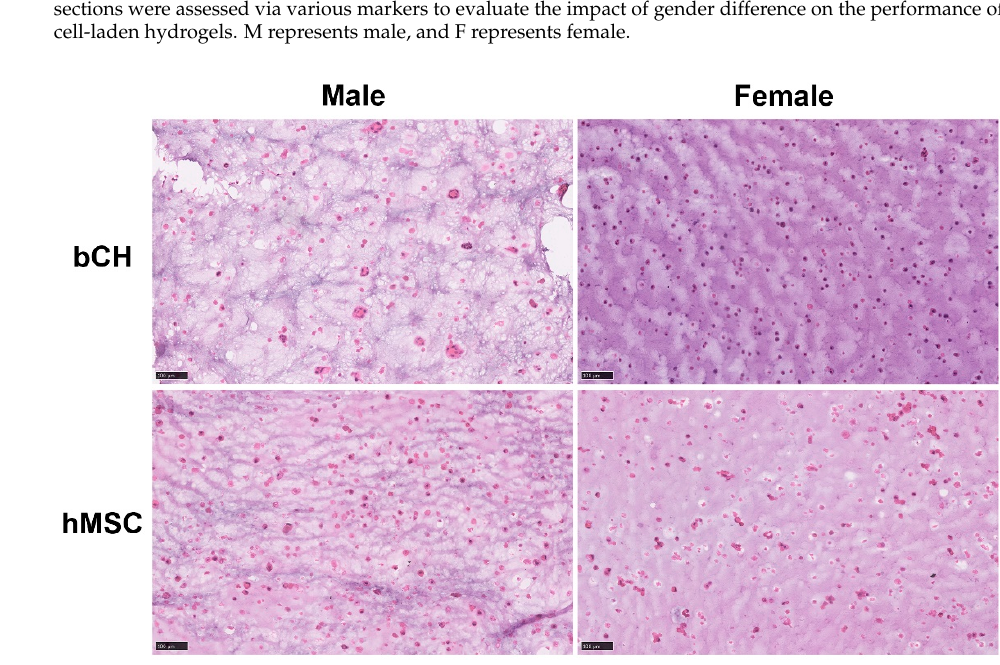
Figure 6. Histological analysis comparing implants laden with bCHs or hMSCs in either male (left) or female (right) nude rats. 5% w / v HA/Dex hydrogels laden with hMSCs or bCHs were implanted subcutaneously into the backs of both male and female rude rats. Representative histological sections of hydrogel samples stained with H&E. Scale bars represent 100 μ m.